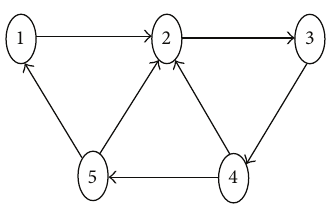
Figure 1: The communication topology graph of these vessels.